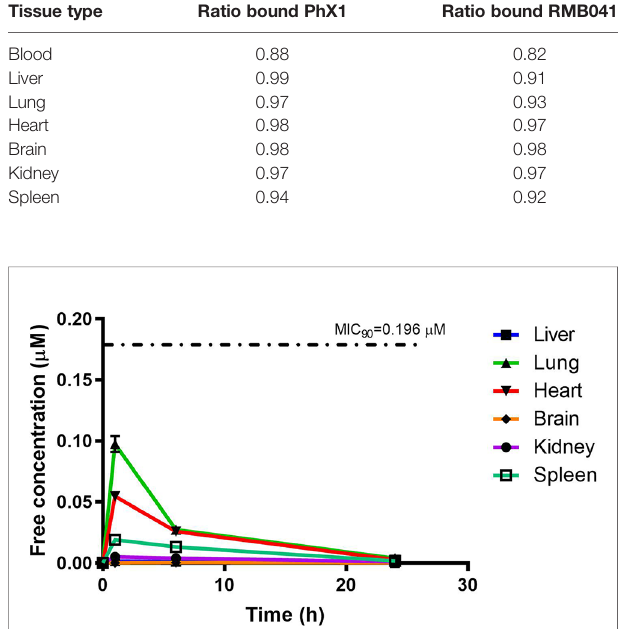
FIGURE 6 | Free concentration of PhX1 (µM) following correction according to tissue binding.